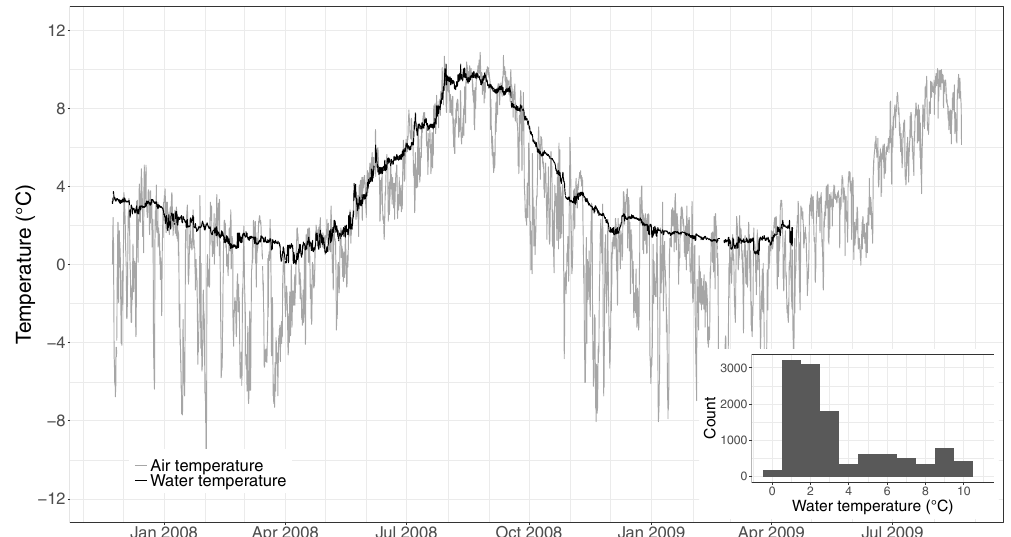
Figure 8. Measurements of water temperature ( ◦ C) at 1.5m depth. Air temperature is shown in the background. A histogram of water temperature measurements is